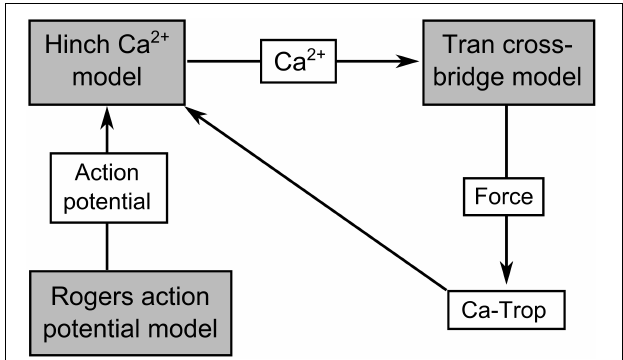
FIGURE 1 | Schematic of the THR excitation-contraction model. The connections indicate the coupling between the Tran et al. (2017) cross-bridge model, the Hinch et al. (2004) Ca 2 + model, and the Rogers and McCulloch (1994) action potential model. Ca-Trop represents Ca 2 + bound to troponin-C, which is modulated by active force, and therefore mediates the mechano-calcium feedback